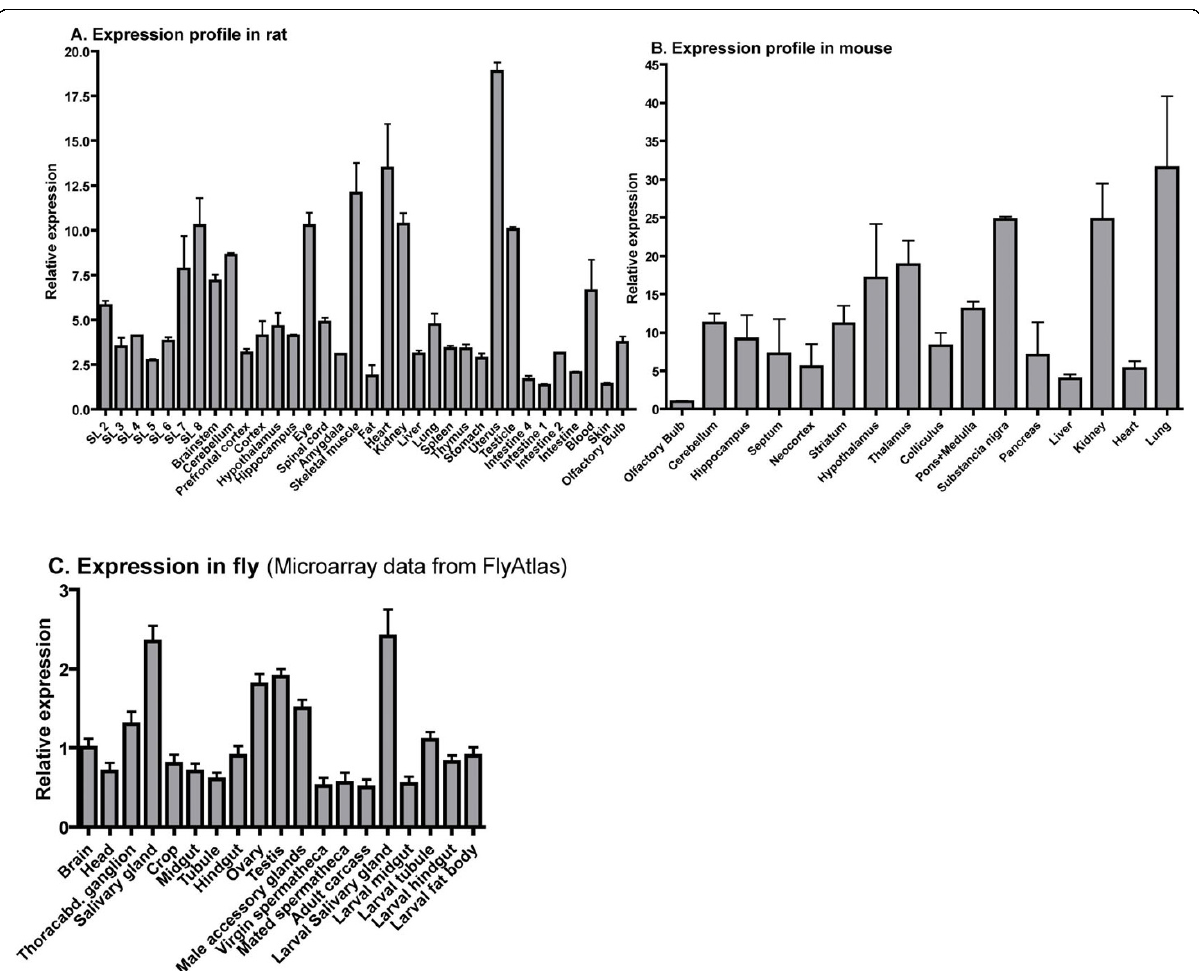
Figure 4 TMEM18 tissue distribution in rat, mouse and fly . Relative mRNA expression of the TMEM18 gene was investigated in three species. Means are relative to the tissue with the lowest expression (set to 1) in the rat and mouse. The expression was measured with real-time PCR for A . Rat and B . Mouse, whereas the expression of TMEM18 in C . fly was received from the FlyAtlas microarray database, the expression is relative to the whole fly. All error bars represent